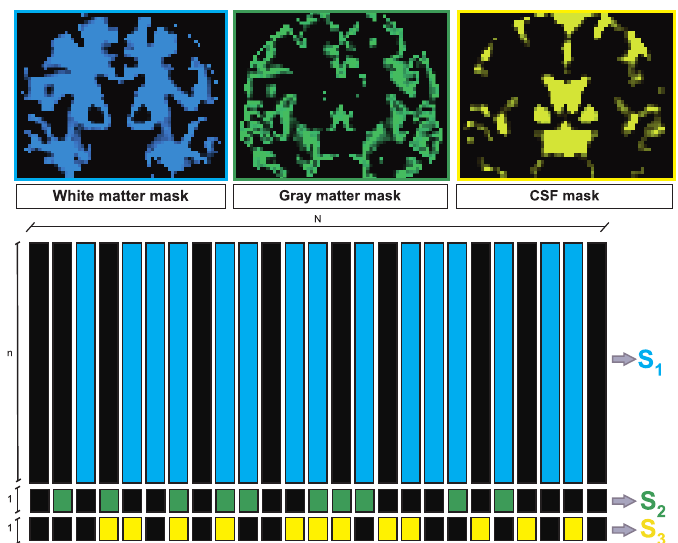
Figure 1. Schematic representation of the matrices S 1 , S 2 and S 3 involved in the FOD reconstruction. Each column of S 1 spans the FOD coefficients of the voxels containing white matter tissue (blue columns). Coefficients modeling gray matter and CSF are stored in S 2 (green columns) and in S 3 (yellow columns), respectively. The FOD reconstruction is performed by estimating S 1 , S 2 and S 3 , whose active columns are provided by the tissue segmentation maps